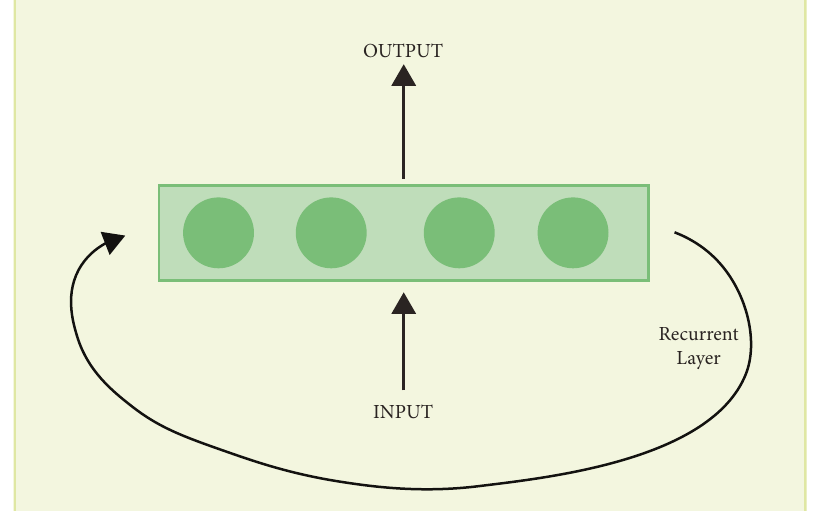
Figure 14: Recurrent neural network.